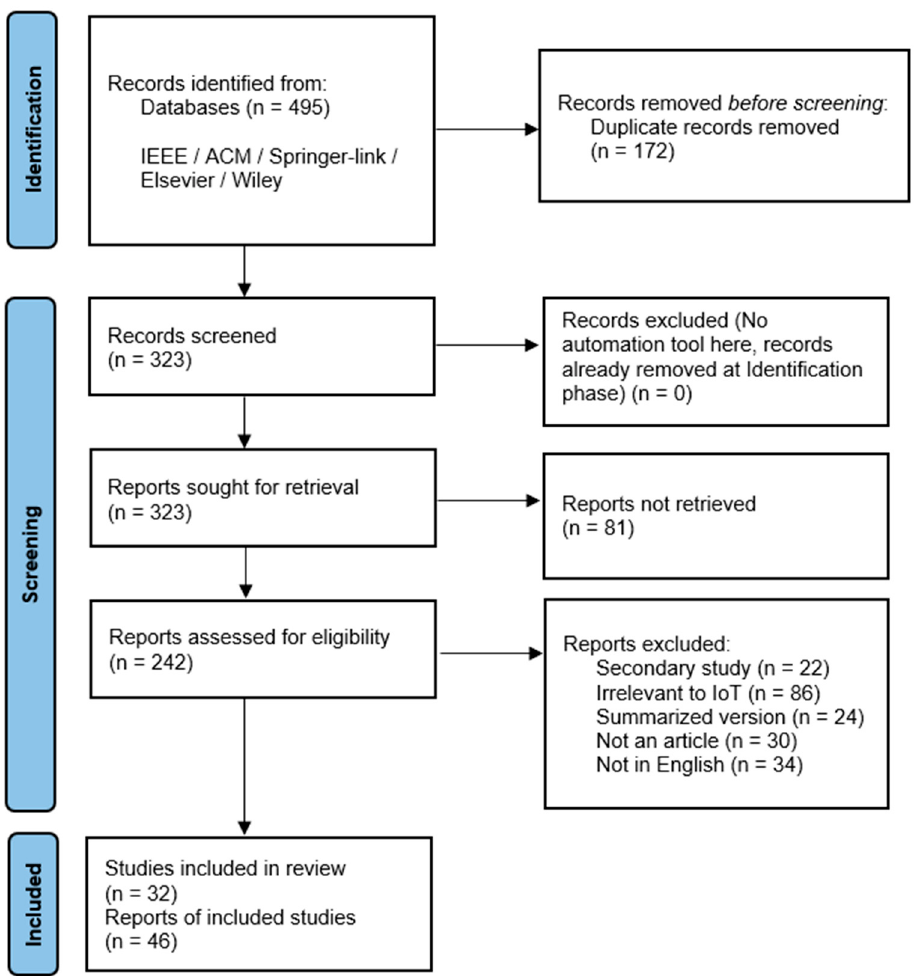
Figure 1. The flow-chart diagram for our screening and reviewing process of the collected papers on the IoT modeling languages using the PRISMA guideline [80].